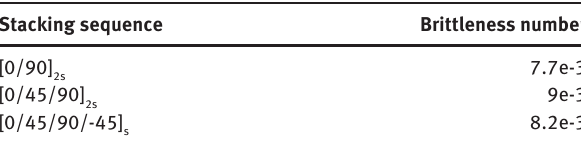
Table 11 Brittleness number with different unnotched stacking sequences.